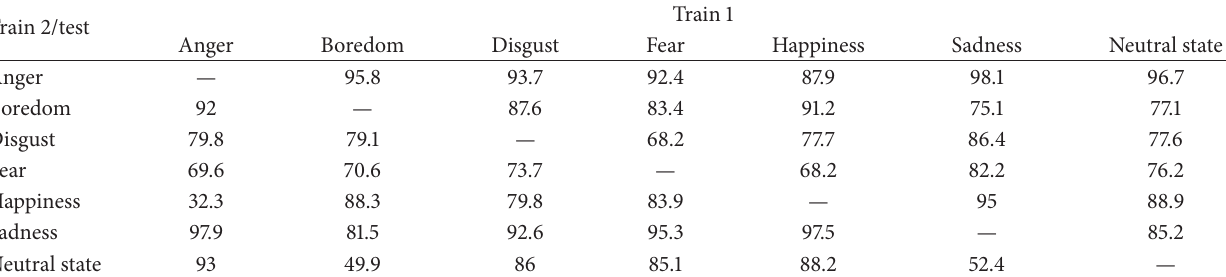
Table 8: Feed forward backpropagation neural network classification accuracy for different combinations of emotions [%]. Train